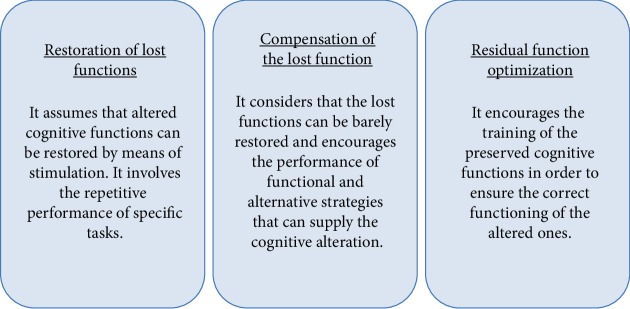
REHACOP's three basic principles [13].